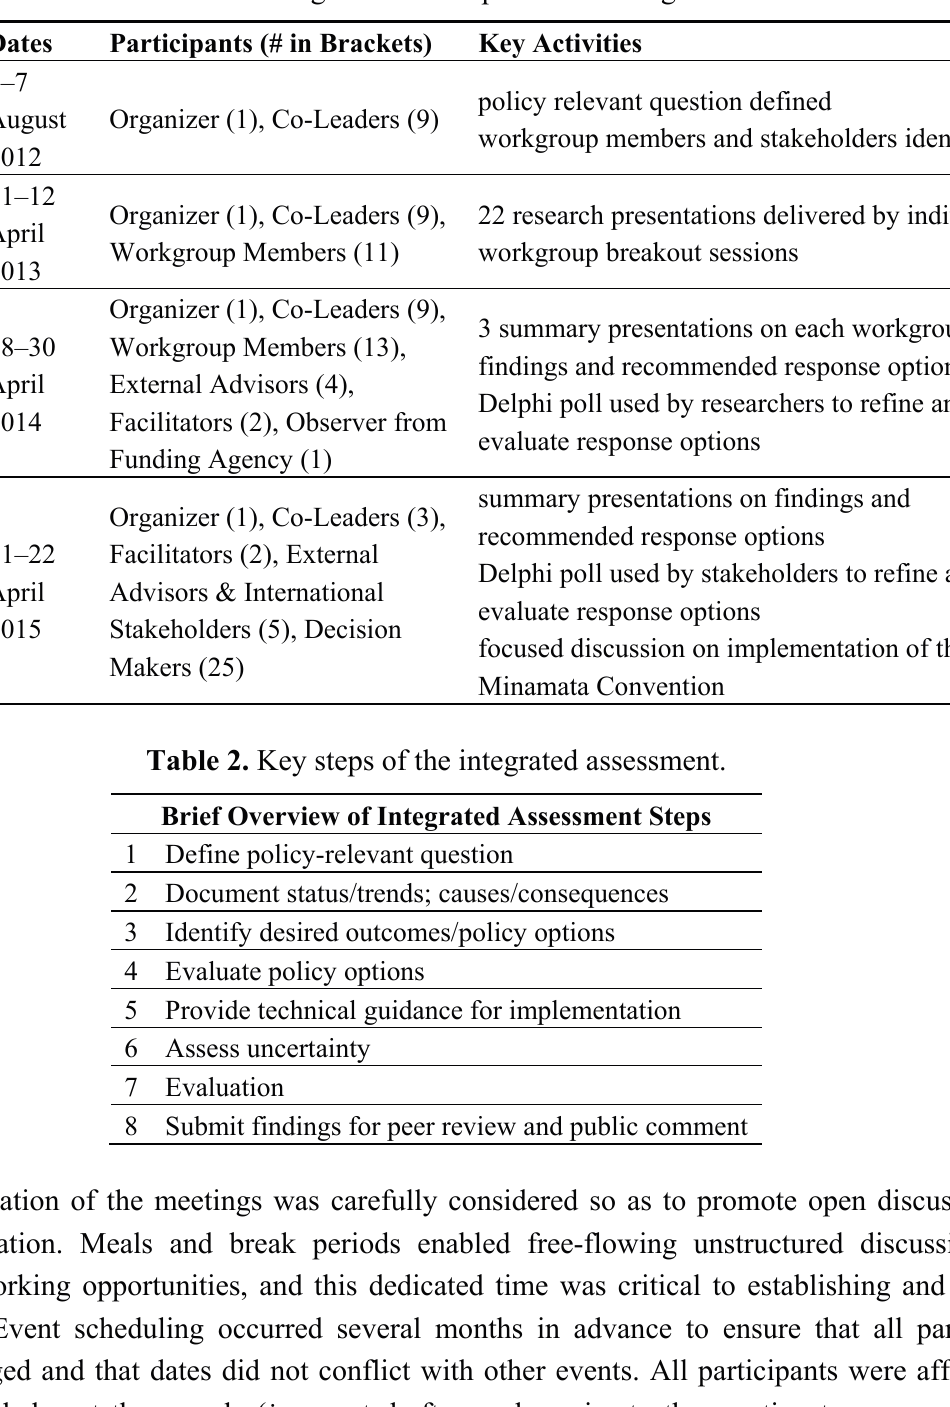
Table 1. Outline of meeting activities as part of our integrated assessment.